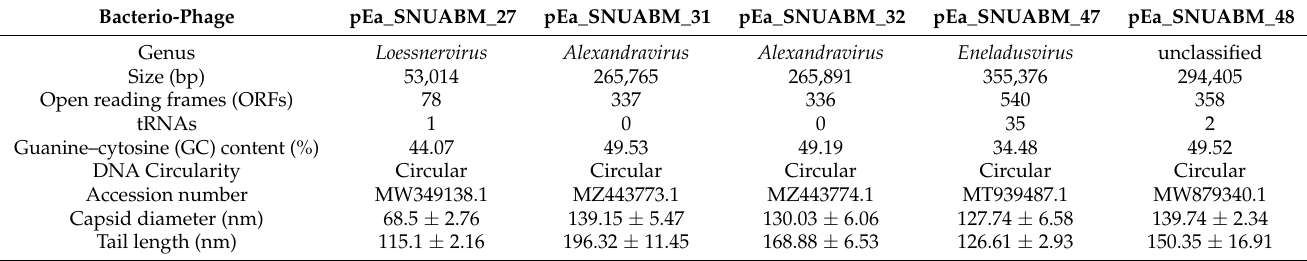
Figure 1. Transmission electron micrographs of Erwinia bacteriophages ( a ) ϕ 27, ( b ) ϕ 31, ( c ) ϕ 32, ( d ) ϕ 47, and ( e ) ϕ 48. Scale bar is 100 nm. The contractile tails of ϕ 32, ϕ 47, and ϕ 48 were observed in the contracted state ( c – e ). Table 1. General features of genomes of Erwinia phages pEa_SNUABM_27, pEa_SNUABM_31, pEa_SNUABM_32, pEa_SNUABM_47, and